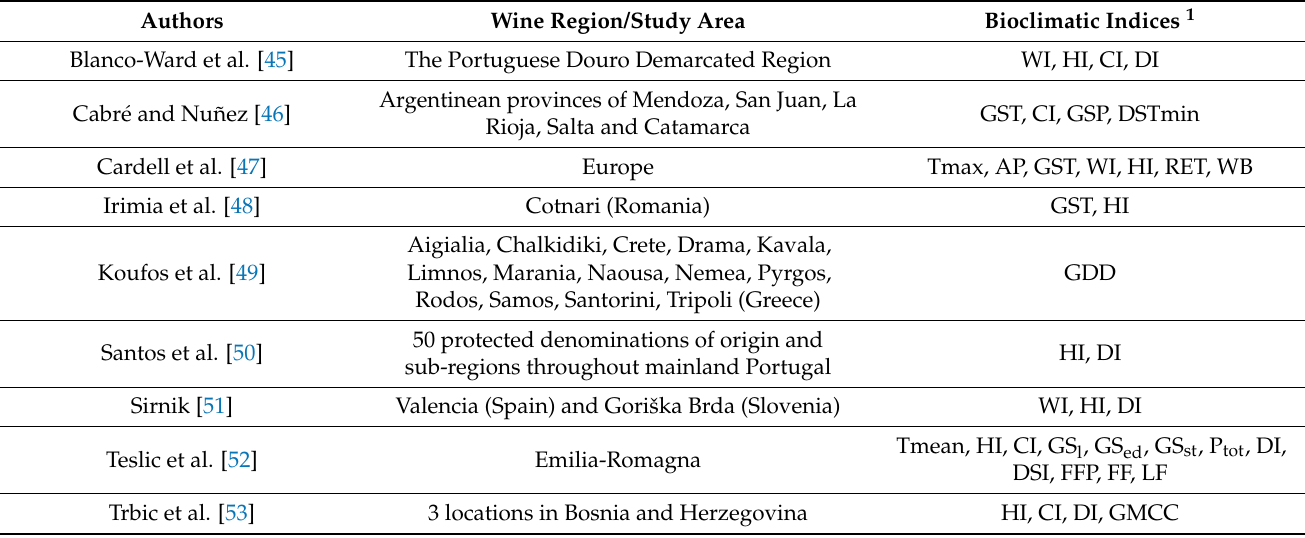
Table 1. A summary of recent studies that have evaluated the impacts of climate change to viticulture using bioclimatic indices and downscaled future climate